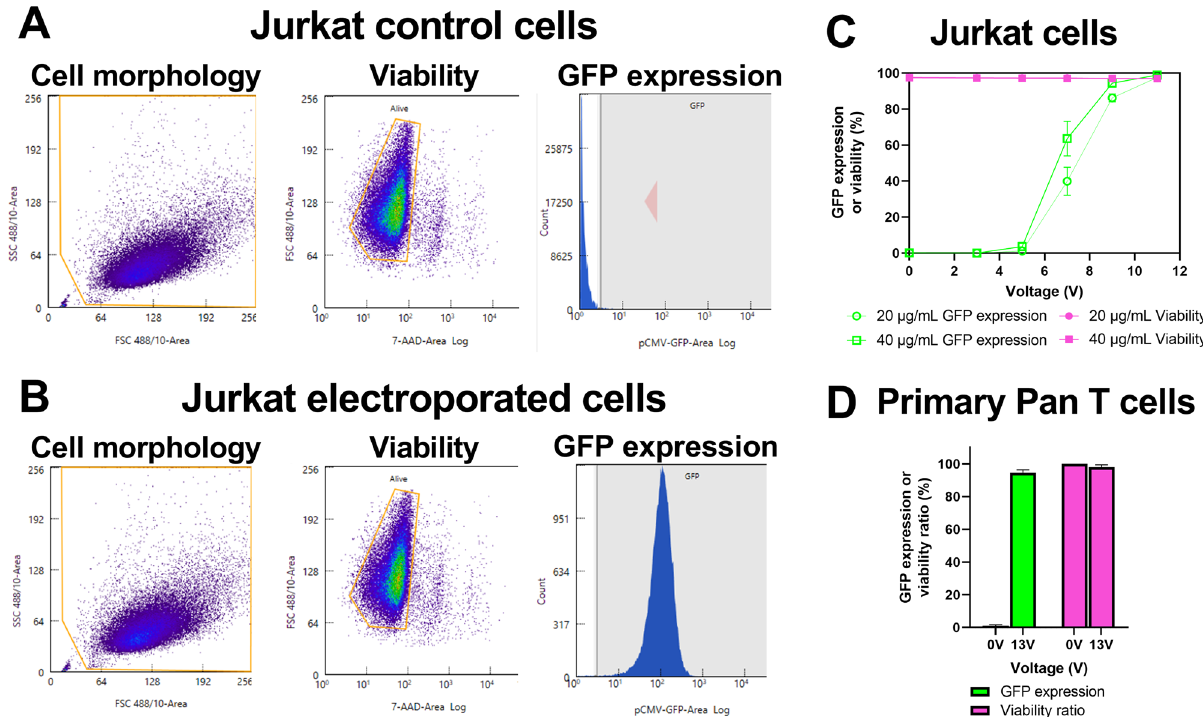
Figure 3. Delivery of mRNA encoding GFP to Jurkat and primary T cells. ( A ) Representative flow cytometry plots from zero voltage-control or ( B ) electroporated Jurkat cells depicting cell morphology, viability, and GFP expression. ( C ) Impact of varying waveform voltage amplitude on delivery using 20 or 40 µg/mL mRNA to Jurkat cells ( n = 3). ( D ) High efficiency delivery using 40 µg/mL mRNA for primary T cells from four healthy donors ( n = 4). Data shown as mean ± standard deviation ( C , D ). Some error bars are too small to be visible ( C